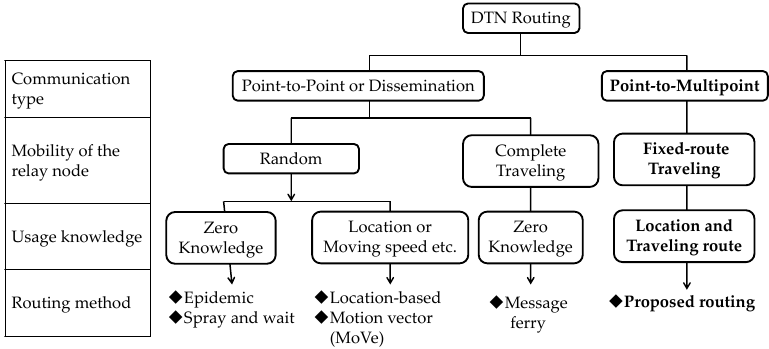
Figure 1. Classification of existing and proposed delay/disruption tolerant networking (DTN) routing